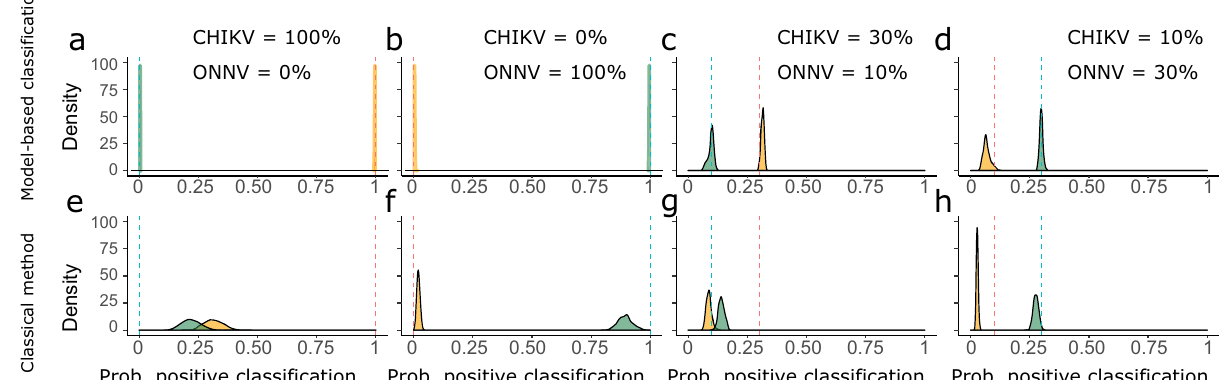
Fig. 4 Performance of the classical and model-based classi fi cation methods in a simulation study. The densities represent the posterior probability of classifying an individual as CHIKV (yellow) or ONNV (green) positive with the model ( a – d ) and the classical method ( e – h ) using simulated serological surveys. We considered four different scenarios where the prevalence of CHIKV and ONNV is (CHIKV: 100%; ONNV: 0%) in panels a and e , (CHIKV: 0%; ONNV: 100%) in panels b and f , (CHIKV: 30%; ONNV: 10%) in panels c and g and (CHIKV: 10%; ONNV: 30%) in panels d and h . The dashed vertical lines give the simulation values for the prevalence of CHIKV (yellow) and